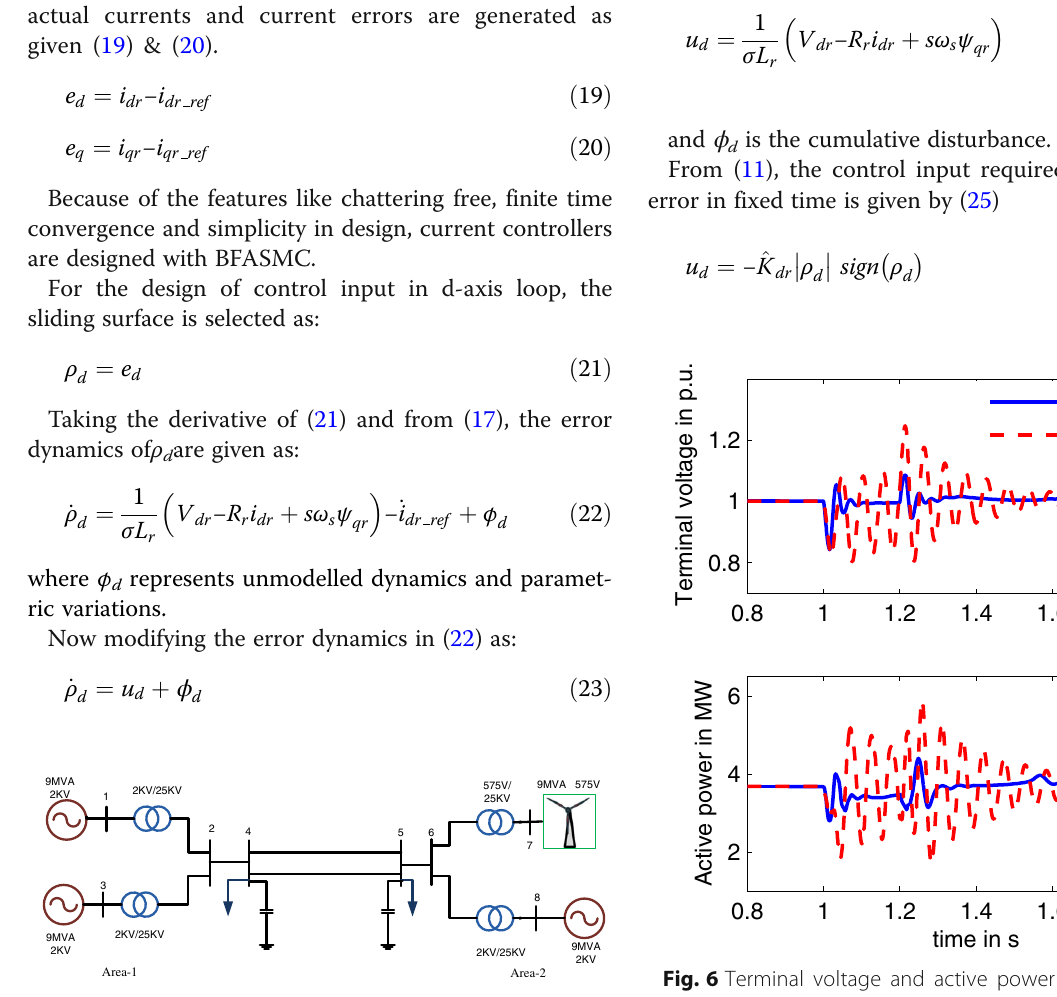
Fig. 4 Benchmark multi-machine power system